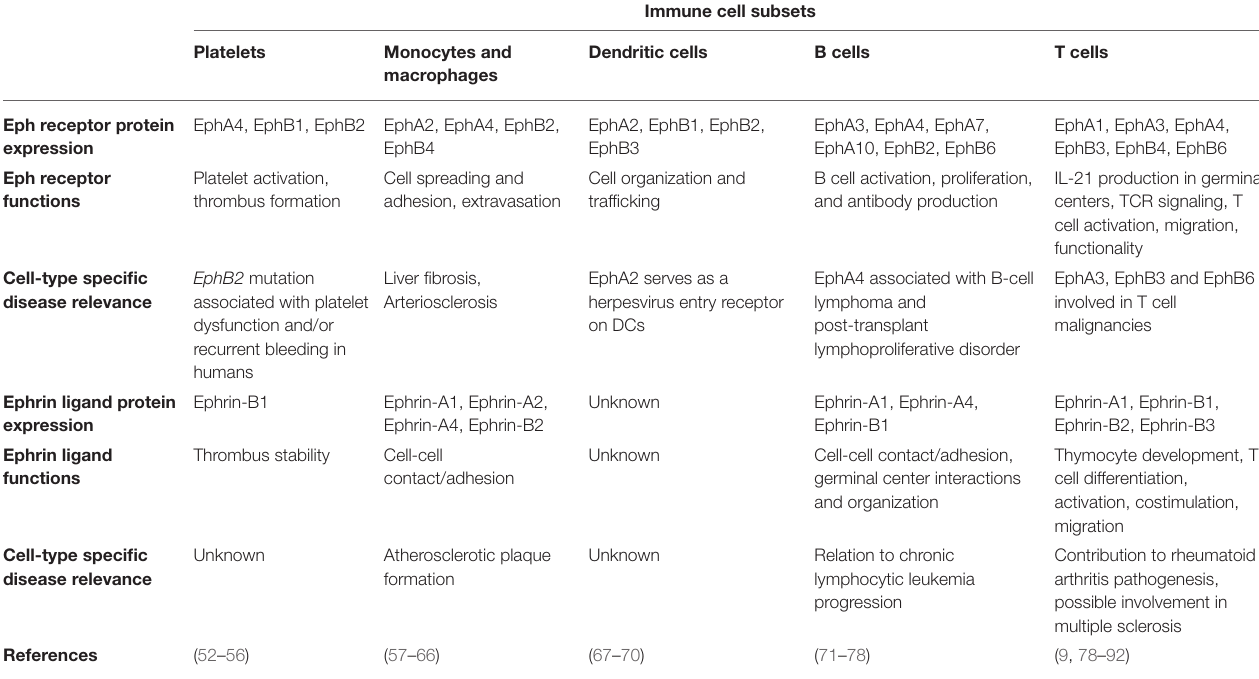
TABLE 2 | Known protein expression profiles, functions, and disease contributions of Eph receptors and ephrin ligands on various immune cell subsets. Immune cell subsets Platelets Monocytes and Dendritic cells B macrophages